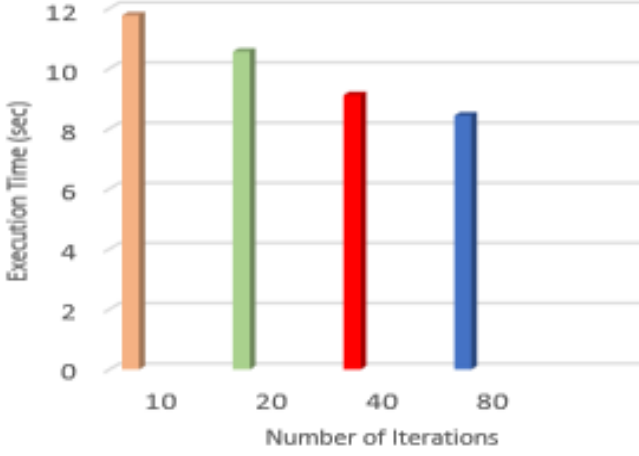
Fig. 15. The execution time of the GWO Algorithm for Case 2.